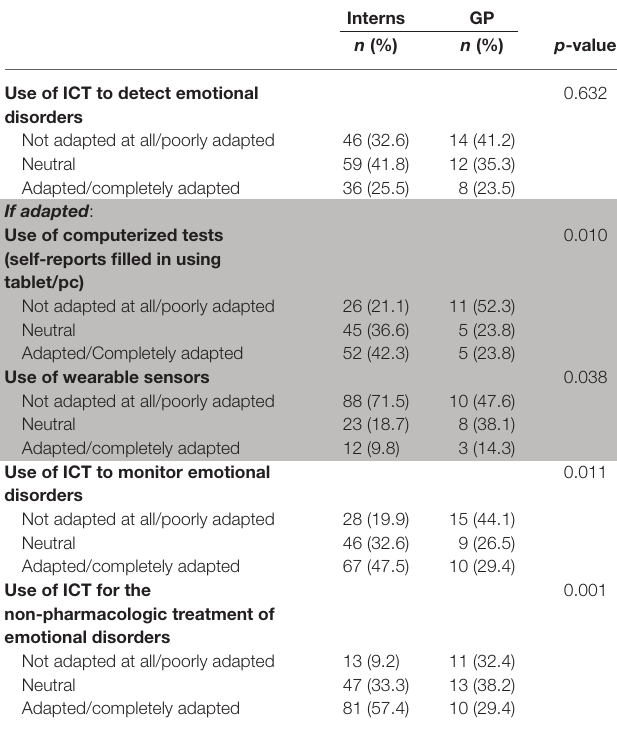
TABLE 2 | Use of information and communication technologies (ICT) in the general population.